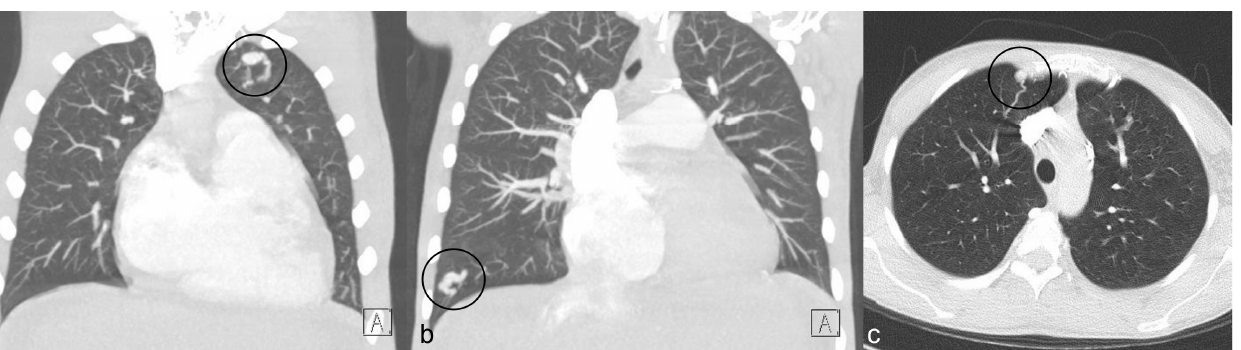
Maximum Intensity Projection .